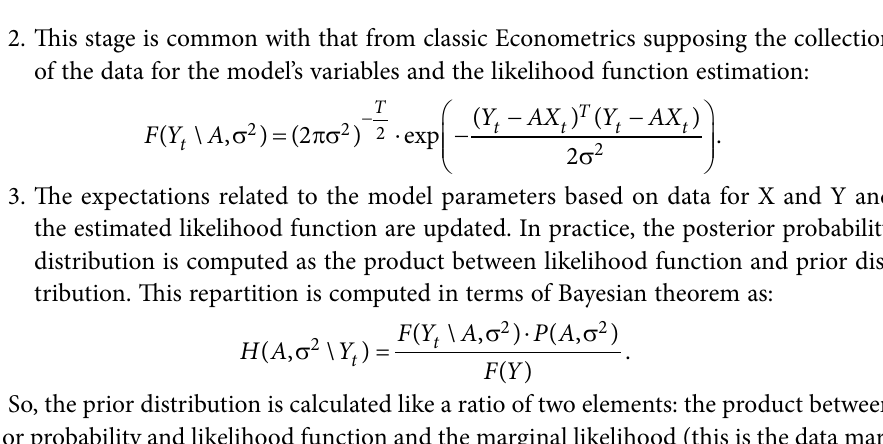
Table 2. The results of unit root tests GDP rate VAT rate Unit root test